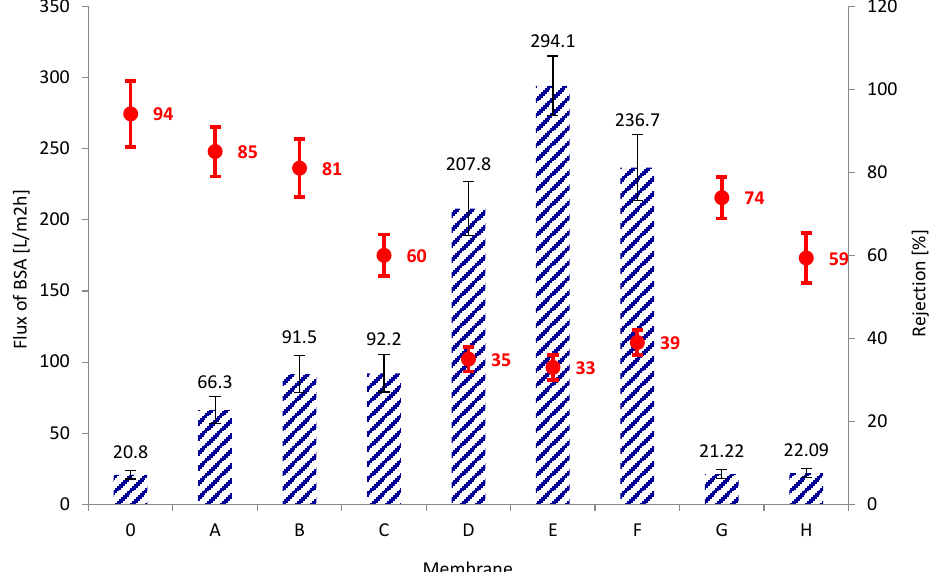
Figure 5. The volumetric permeate flux and rejection coefficients for BSA determined for subsequent membranes at a working pressure of 0.2 MPa.